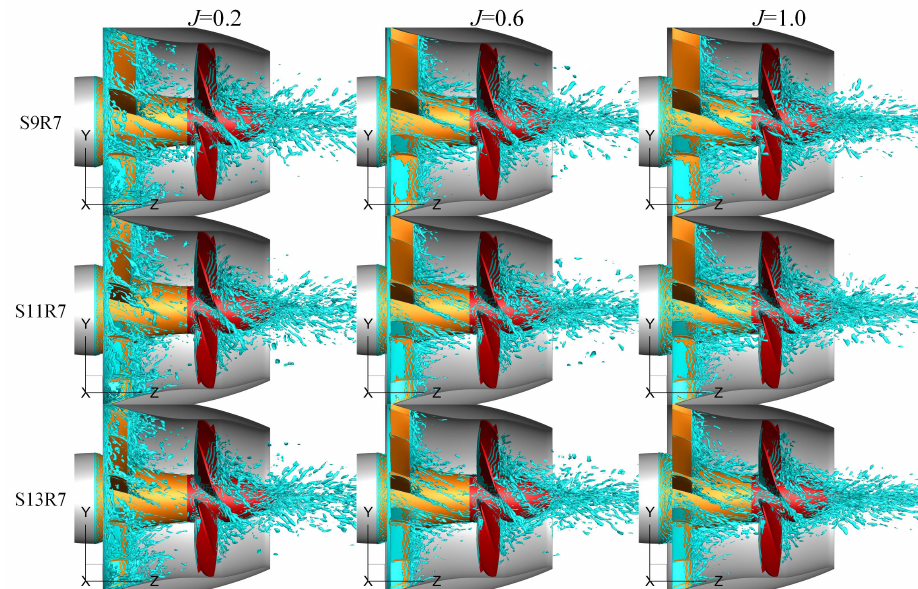
Figure 27. Interaction between the blade wake vortices of the rotor and stator of PJP models withholding the rotor blade numbers.